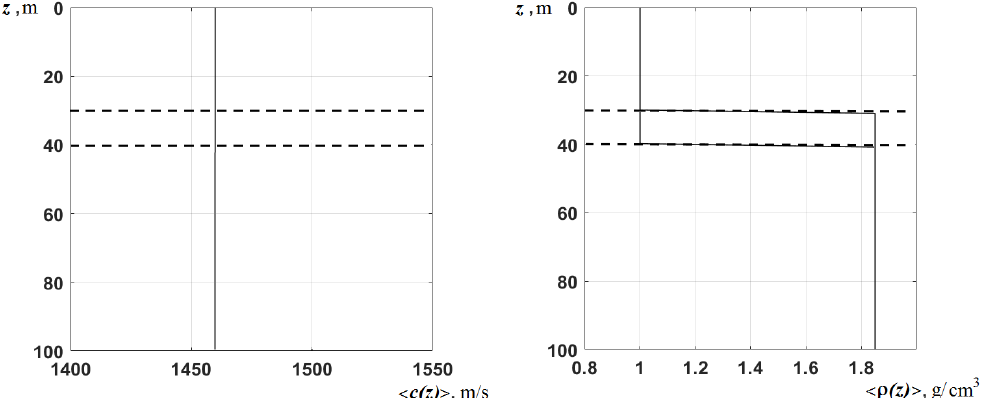
Figure 1. Average profiles of the speed of sound (cid:104) c ( z ) (cid:105) = (cid:104) c 1 ( z ) (cid:105) = 1460 m/s and density (cid:104) ρ ( z ) (cid:105) in the waveguide with the liquid bottom. Dotted lines show the bottom boundary location for two examples.